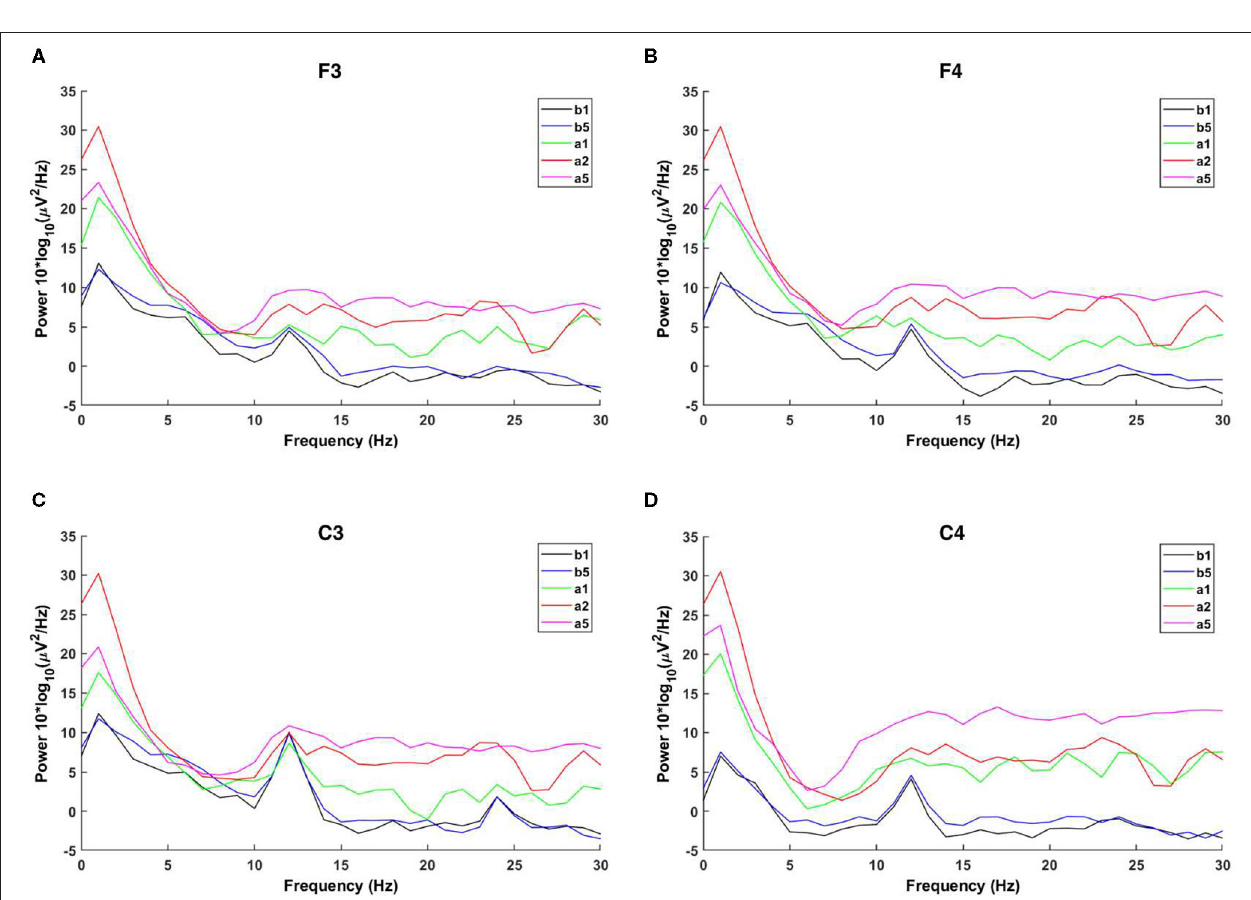
FIGURE 4 | Power spectra. The power spectra of b 1 are shown as black lines, the power spectra of b 5 are shown as blue lines, the power spectra of a 1 are shown as green lines, the power spectra of a 2 are shown as red lines, and the power spectra of a 5 are shown as pink lines. (A) Shows the power spectra of F3 area, (B) shows the power spectra of F4 area, (C) shows the power spectra of C3 area, and (D) shows the power spectra of C4 area.